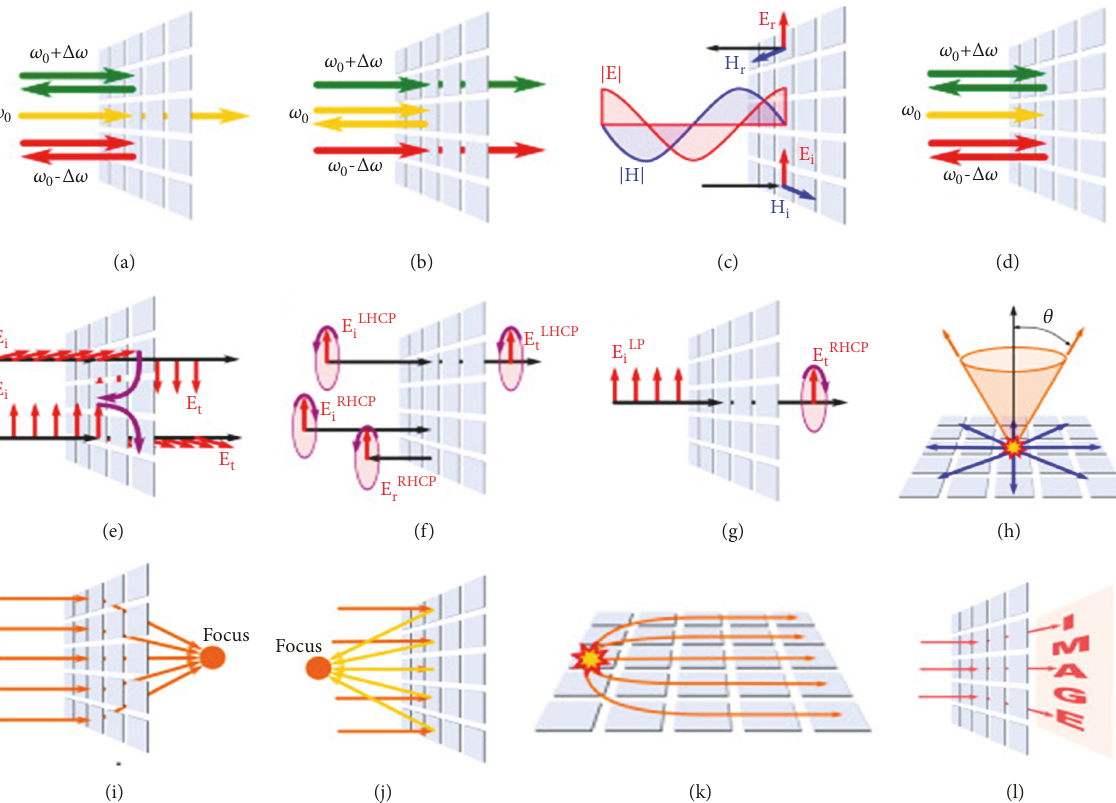
Figure 1: Selected functionalities of metasurfaces: (a) band pass frequency selective surface; (b) band stop frequency selective surface; (c) high-impedance surface; (d) narrowband perfect absorber; (e) twist polarizer; (f) right-handed circular-polarization frequency selective surface; (g) linear-to-circular polarization converter; (h) two-dimensional leaky-wave antenna with a conical-beam pattern; (i) focusing transmit array; (j) focusing reflect array; (k)flat Luneburg lens; (l) hologram [18].